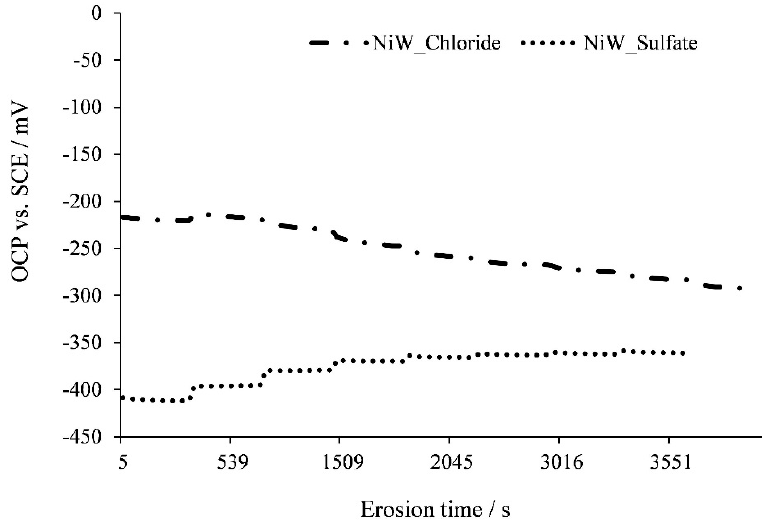
Figure 5. Changes in the OCPs of the coated samples during erosion – corrosion test.